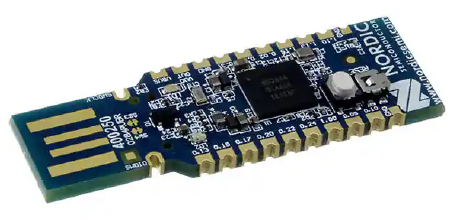
Figure 10. Nordic USB Dongle used for Bluetooth Low Energy (BLE) communication